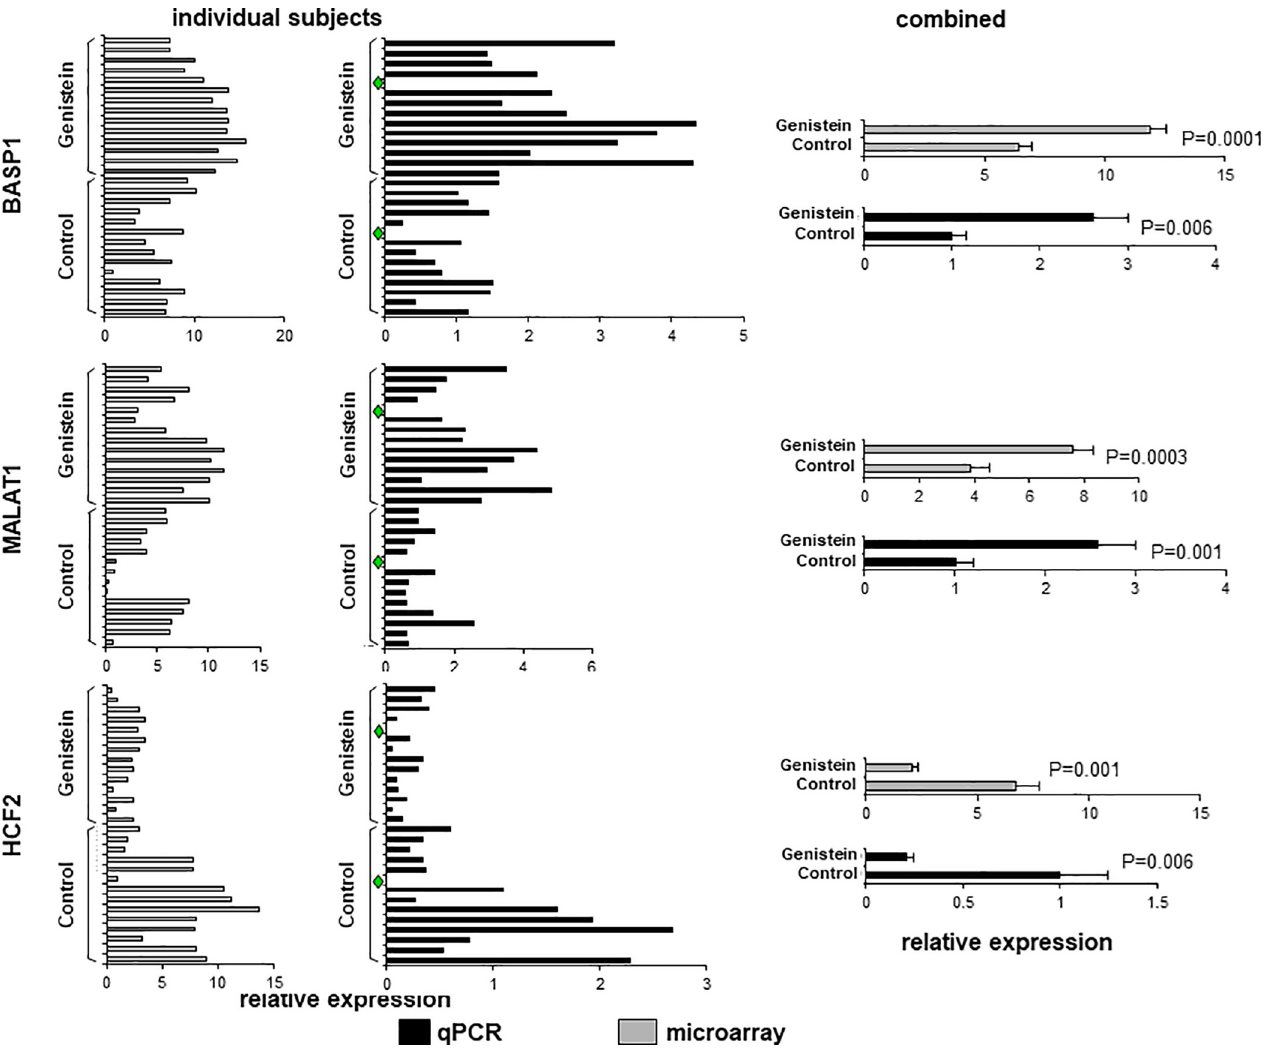
Fig 1. Evaluation of gene expression by qRT/PCR. For each of three genes denoted, the left charts depict mean level of gene expression for each subject by microarray (N = 1) or qRT/PCR (N = 3), as indicated, and as described in S2 Fig. The right charts combine all data for genistein treated or controls. Student’s 2-sided P-values for differences between genistein treatment and controls are depicted. Green diamonds: sample not sufficient to support qRT/PCR analysis.